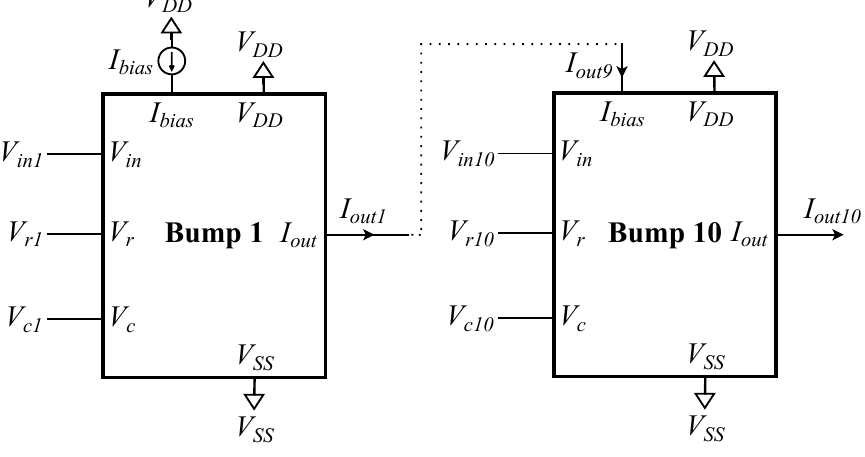
Figure 3. By connecting 10 simple bump circuits sequentially, the output of the last one is equivalent to a 10-D Gaussian function. Each bump circuit’s parameters ( V r , V c , I bias ) are tuned